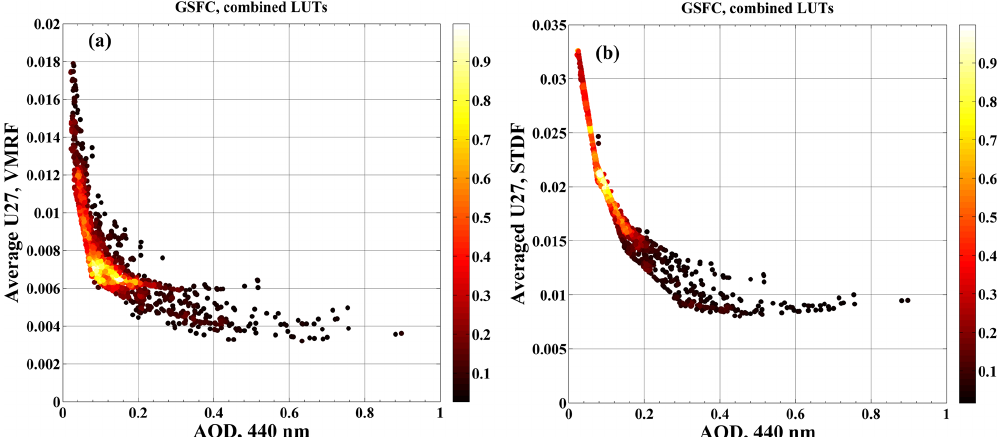
Figure 26. Uncertainties for (a) volume median radius of fine mode and (b) width of size distribution for fine mode estimated at the GSFC site.